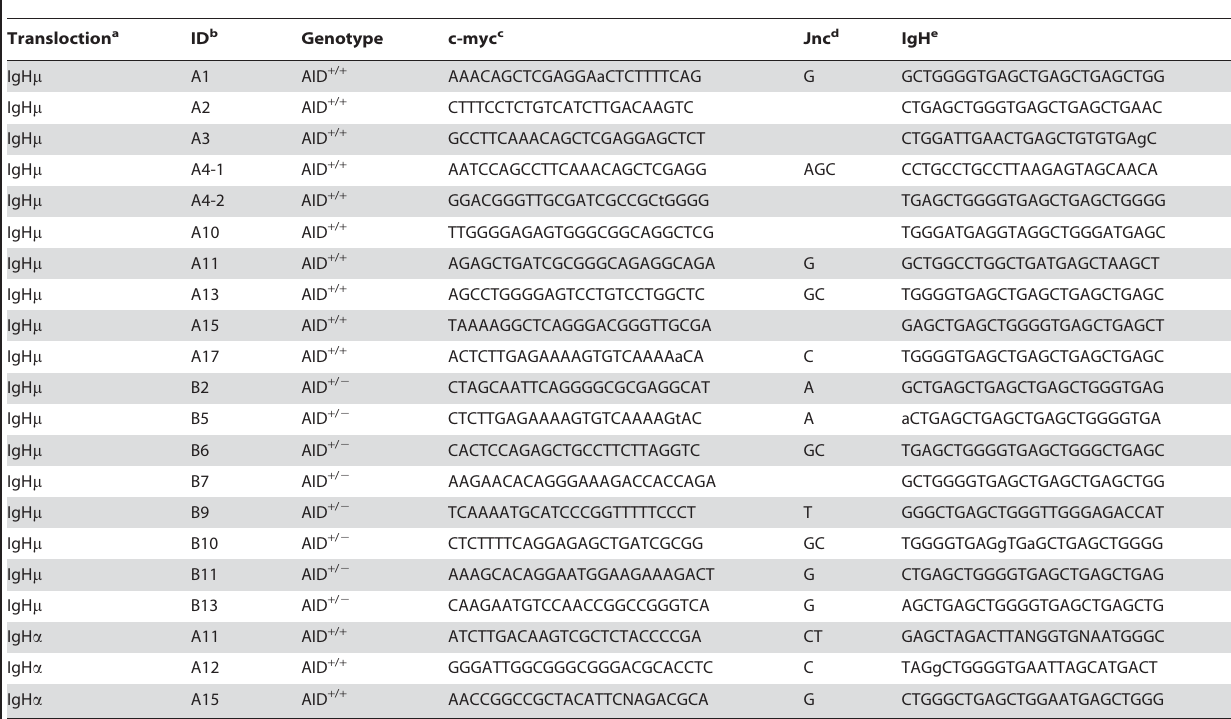
Table 1. c-myc/IgH chromosomal translocations in IL6tg mice